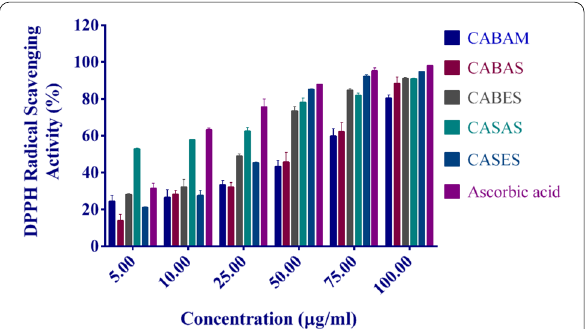
Fig. 1 DPPH radical scavenging activity of C. albidum extracts. Values represent mean standard deviation ( n 3). CABAM C. albidum bark ± = acetone extract obtained by maceration for 30 min, CABAS C. albidum bark acetone extract obtained by sonication for 30 min, CABES C. albidum bark ethanol extract obtained by sonication for 30 min,